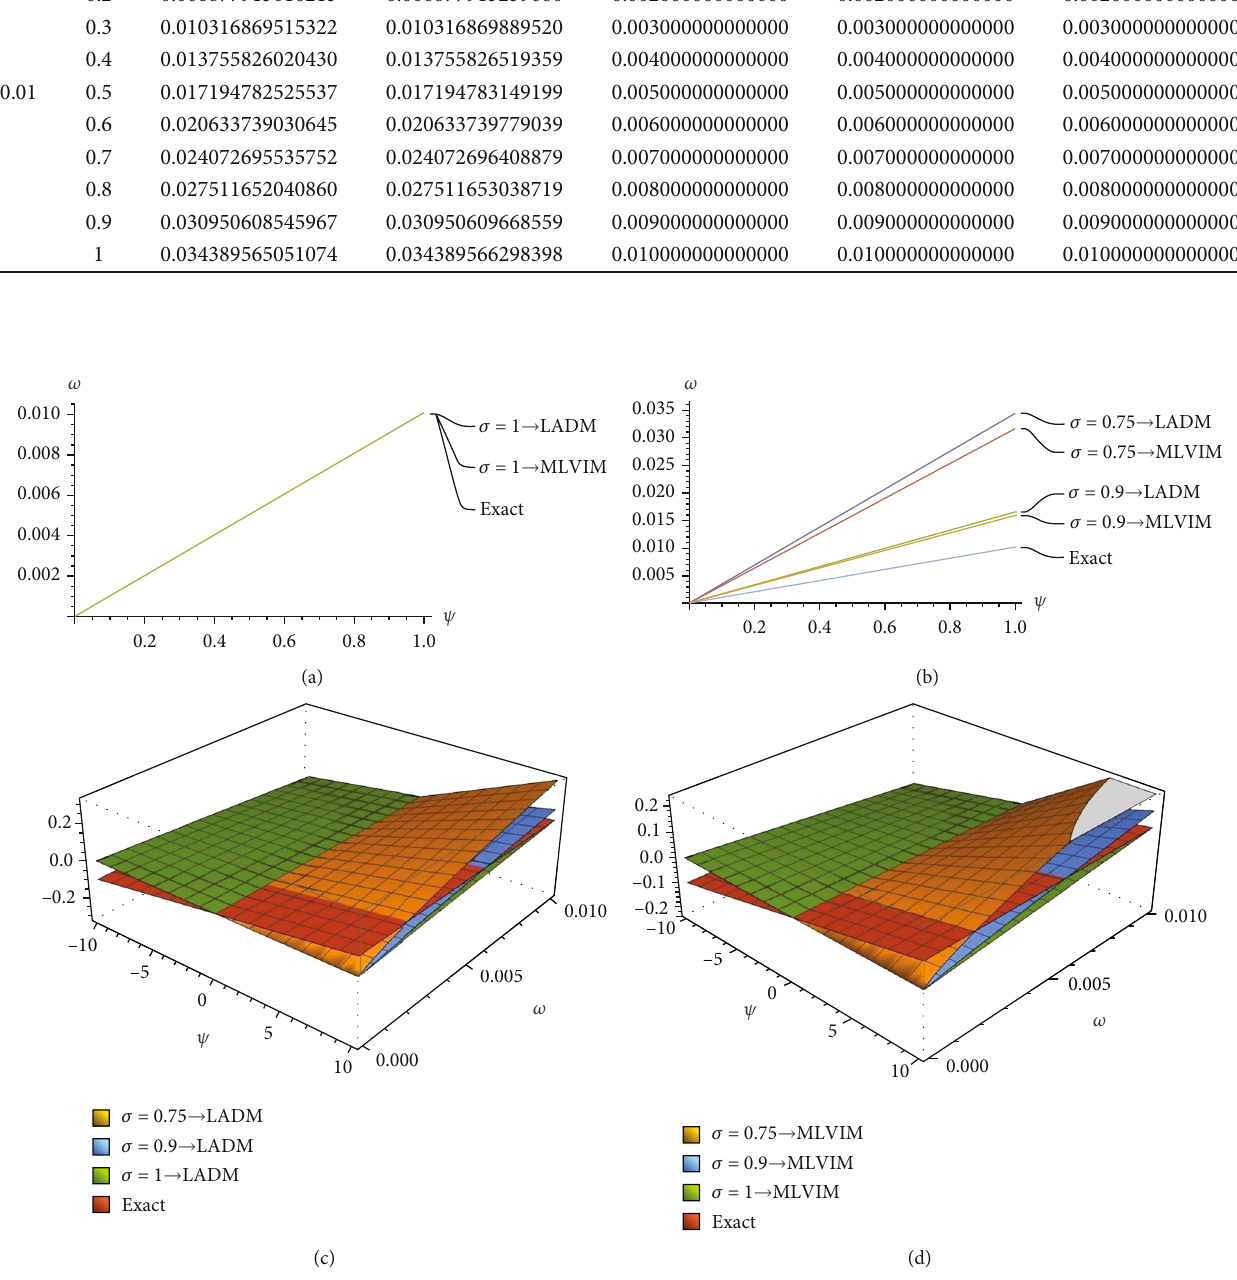
Figure 1: Comparison of LADM and MLVIM solution for the fi rst three approximations with exact solution for ω = 0 : 01 , with mesh points ψ = 0 : 1 , for equation